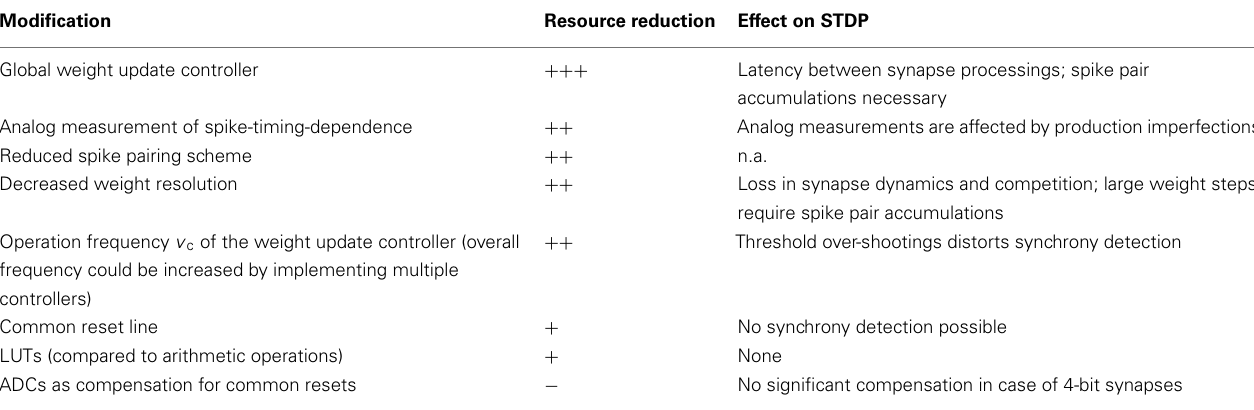
Table 5 | Possible design modifications of hardware synapses, their reduction in terms of required chip resources and their effects on STDP.